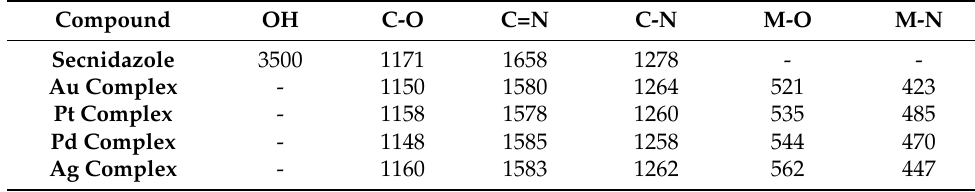
Table 2. Main IR absorption bands of secnidazole and its